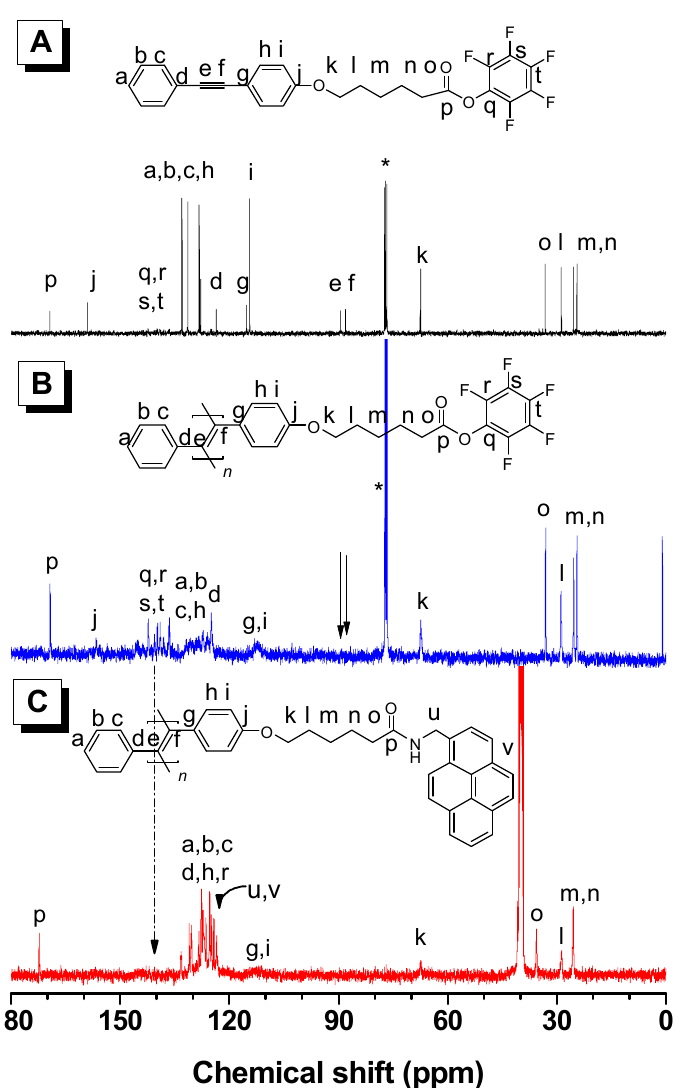
Figure 4. 13 C NMR spectra of ( A ) monomer 1 (in chloroform- d ), ( B ) precursor P 0 bearing activated ester groups (in chloroform- d ), and ( C ) pyrene-functionalized poly(diphenylacetylene) derivative P 1 (in DMSO- d 6). The solvent and water peaks are marked with asterisks.